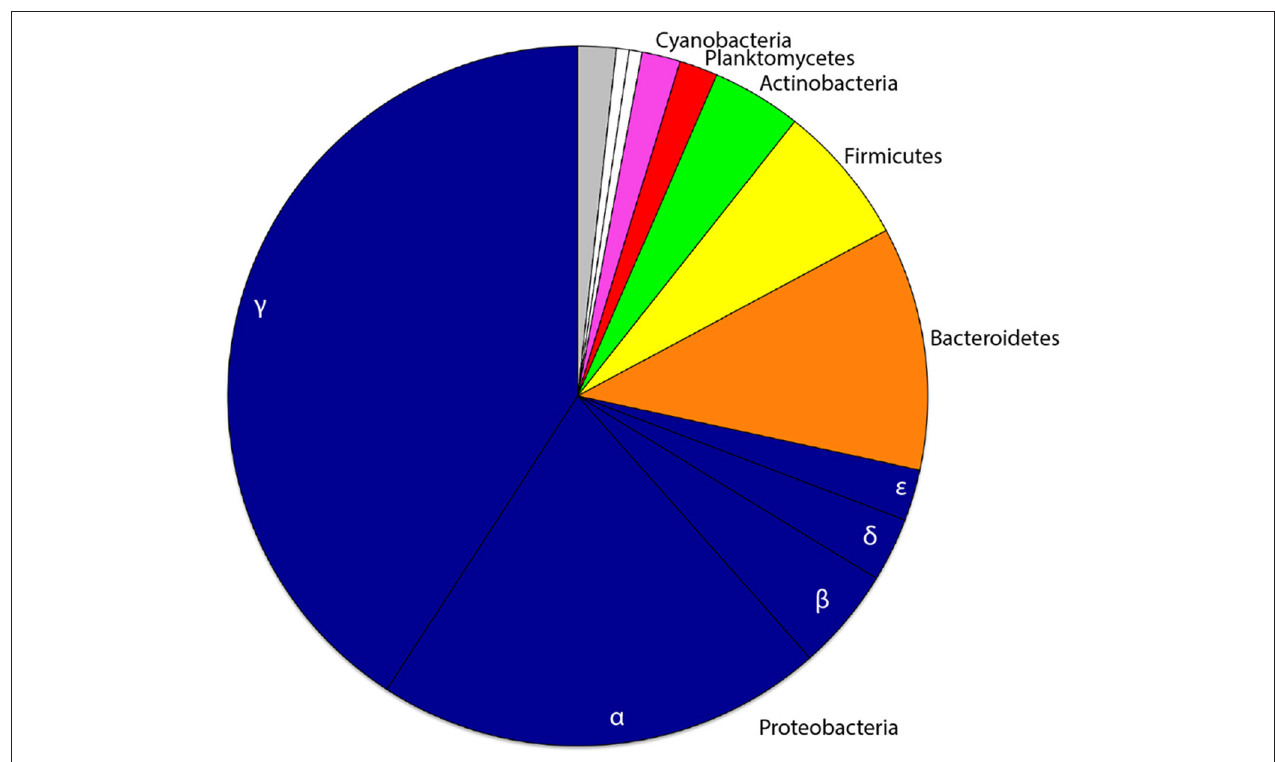
FIGURE 1 | Proportional phyletic representation of bacterial OTUs recovered from one or more developmental stages of the sponge host Amphimedon queenslandica . Common phyla (taxonomic representation ≥ 1% across pooled developmental samples) are depicted in color, rare phyla (taxonomic representation ≤ 1% across pooled developmental samples) in white, and OTUs unclassified at the phylum level in gray. The class level divisions of proteobacterial OTUs are also